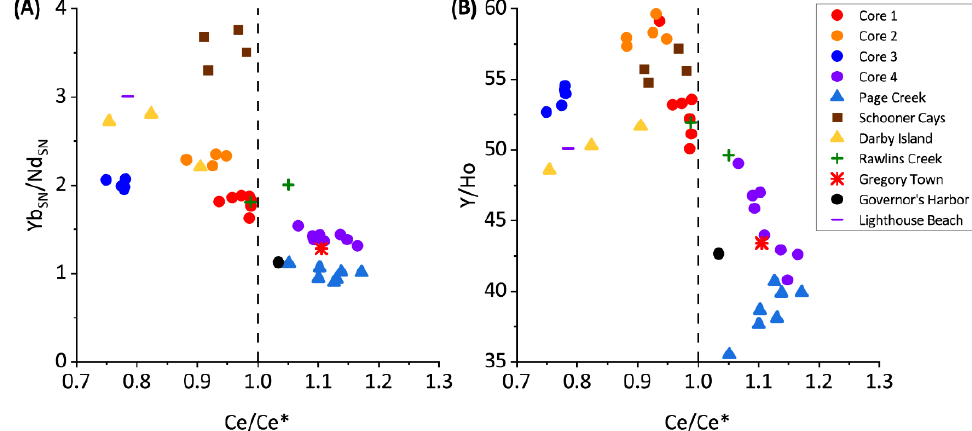
Figure 4. Rare earth geochemistry of the investigated samples.